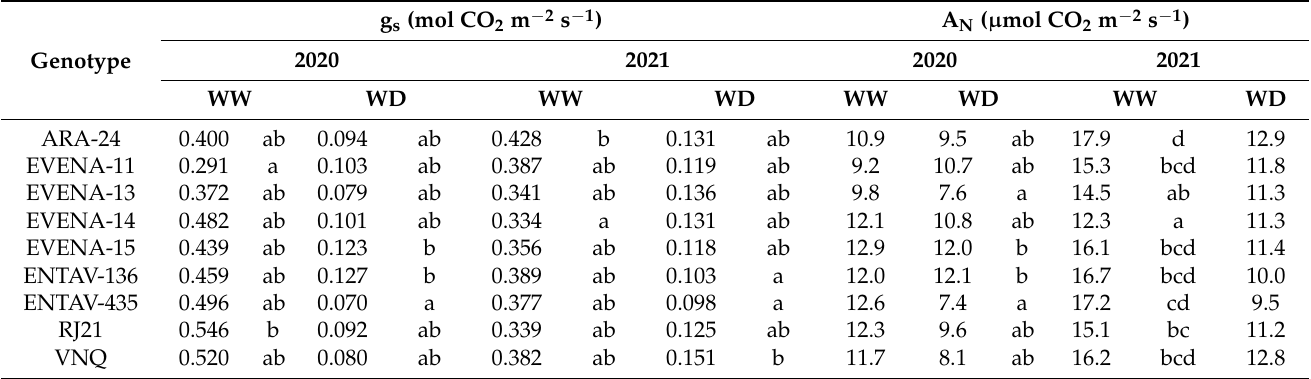
Within each row, different letters indicate significantly different results at p < 0.05 (Duncan test). Table 2. Leaf stomatal conductance (g s ) and net photosynthesis (A N ) for each of the 9 “Grenache” genotypes under well-watered (WW) and water deficit (WD) conditions, grown in Mallorca, Balearic Islands, Spain, during 2020 and 2021